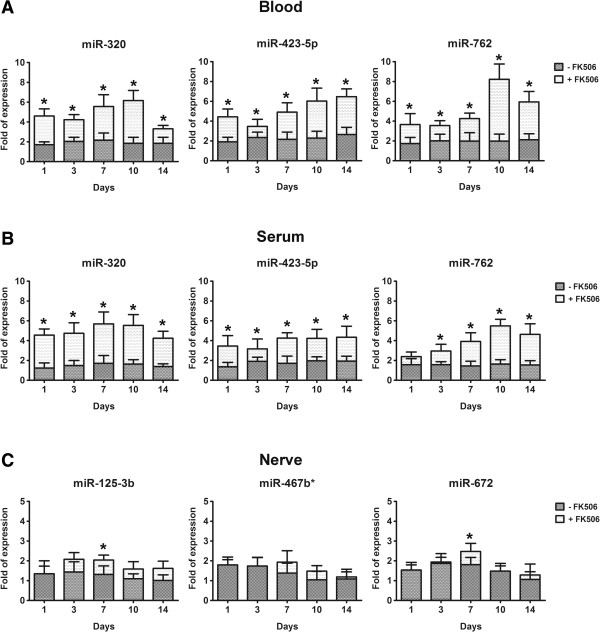
Quantification of upregulated miRNA targets detected by miRNA arrays, by qRT-PCR within 2 weeks after nerve allotransplantation in (A) whole blood, (B) sera, and (C) nerve grafts. Bars represent mean ± SEM values of 6 experiments; *P < 0.05.